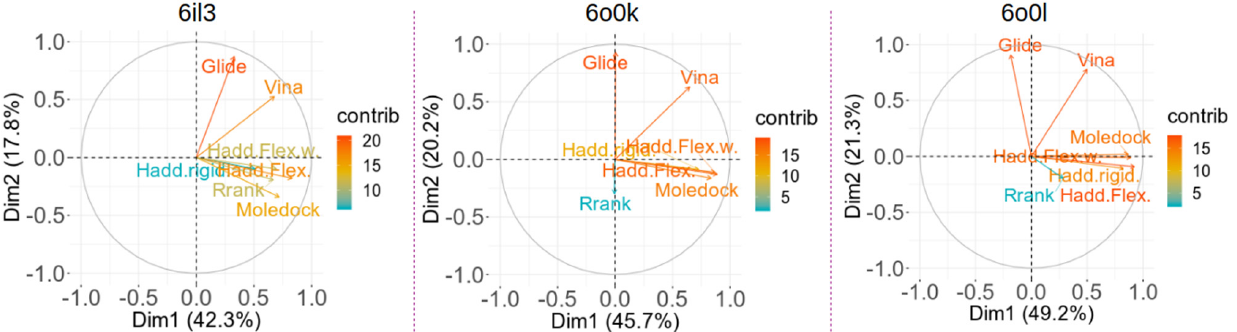
Figure 2. The distribution of the normalized docking scores of all of the molecules across the seven docking scores, showing the level of overlap and mean value (dash line).